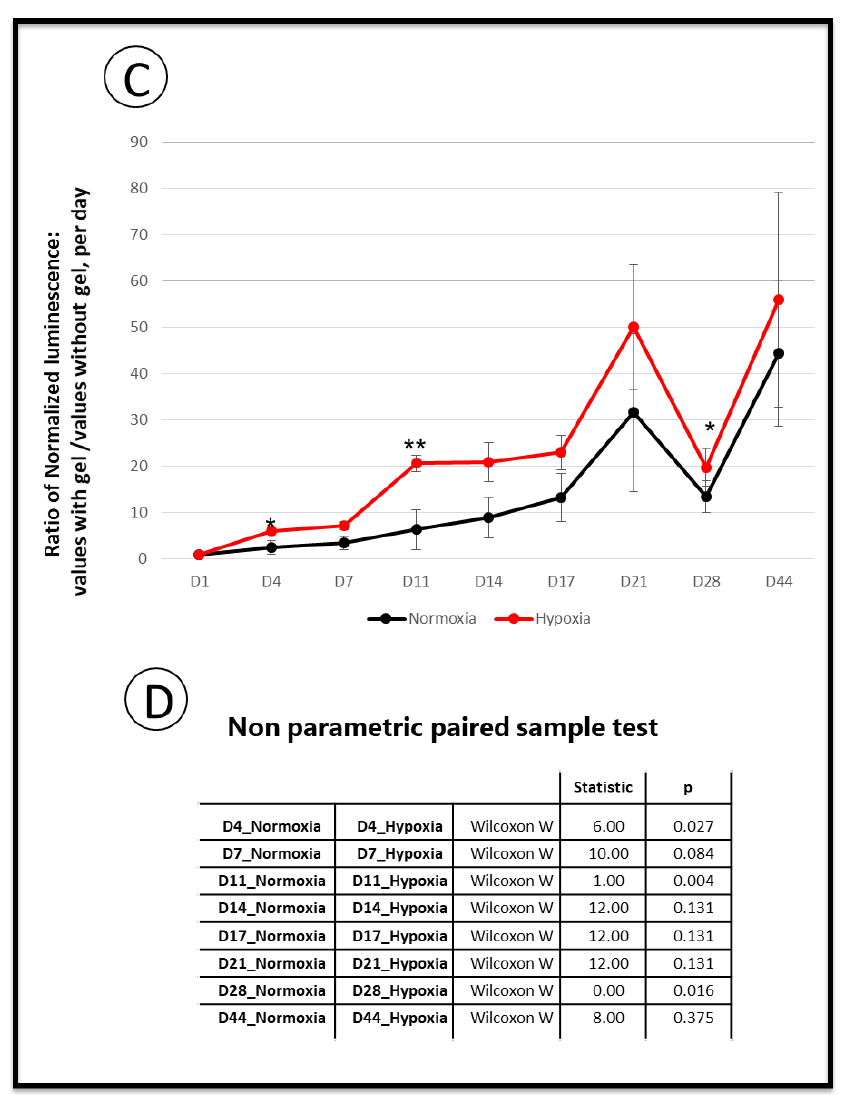
Figure 6. SCAPs survival after implantation. Luminescence measured in mice after subcutaneous implantation of SCAPs-Luc + preconditioned at 3% O 2 , or 21% O 2 and seeded or not in the hydrogel. ( A ) Graphs of the mean + SEM of the decrease of luciferase (Luc) activity over time, of the 4 groups of mice injected with SCAPs alone at 21% O 2 (SCAPs-N1) or at 3% O 2 (SCAPs-H1) or with cellularized hydrogels with cells at 21% (SCAPs-N1 + Hydrogel) or at 3% O 2 (SCAPs-H1 + Hydrogel). All data were calibrated with the first measure of Luc arbitrarily put at 1 (which represents the 100% of luminescence). Detailed data with statistical analysis are in Supplementary Figure S3. ( B ) Graphs of luminescence intensity, normalized for each day with the same mice taken at 1. (Mann–Whitney U, ***: p value < 0.001; **: p value < 0.01; *: p value < 0.05). ( C ) Curves representing the ratio of normalized luminescence of SCAPs-Luc + cells with or without gel as followed: [Cells with hydrogel/cells alone (H, 3% O 2 )] over [cells with hydrogel/cells alone (N, 21% O 2 ), measured at the different days in the engrafted mice, as indicated in the two conditions. Normoxia: 21% O 2 or Hypoxia: 3% O 2 . ( D ), Statistical analysis of the calculated ratio at each day (Wilcoxon signed-rank test, **: p value < 0.01; *: p value < 0.05), shown on ( C ).